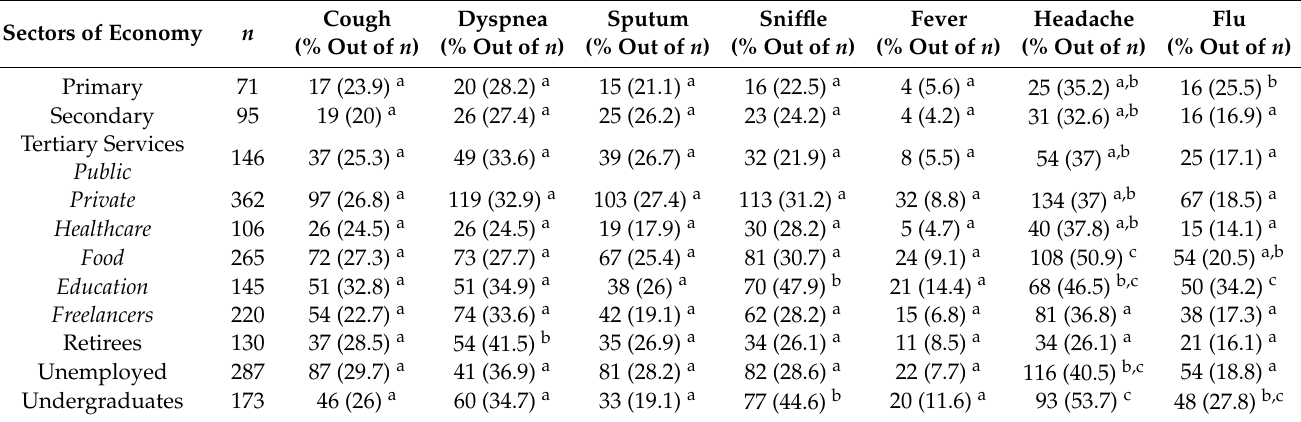
Numbers represent the sum of positive frequencies in 5-point Likert scale questions. Each subscript letter a,b,c denotes a subset of sectors’ categories whose column proportions do not differ significantly from each other at the 0.05